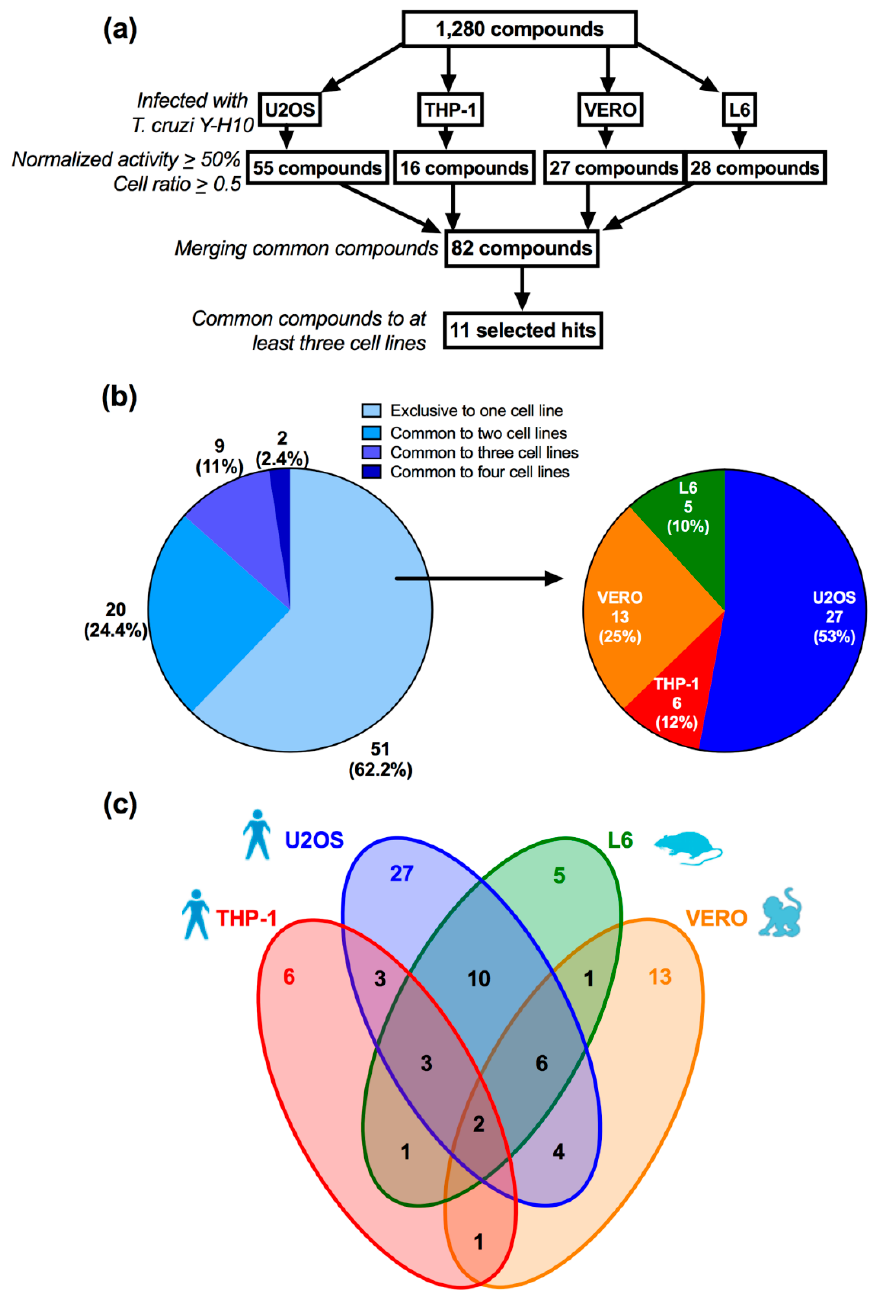
Figure 3. LOPAC 1280 compound library screening scheme and hit selection. ( a ) All 1,280 compounds were screened against each cell line infected with T. cruzi Y-H10 strain: U2OS, THP-1, VERO and L6. Different numbers of potential hit compounds were selected for each host cell assay according to the following criteria: normalized activity superior to 50% and cell ratio higher than 0.5, totaling 82 compounds, of which only 11 were common to at least three cell line screens (selected hits). ( b ) Left: percentage of the selected hits yielded by one (exclusive), two, three or four cell line screens. Right: distribution of the exclusive selected hits by specific cell line. ( c ) Diagram shows distribution and sharing of potential compounds among cell lines: colored numbers indicate the number of exclusive active compounds for each cell line screen, while numbers in the intersection regions show shared potential compounds for the respective cell line. U2OS (blue), THP-1 (red), VERO (orange) and L6 (green).